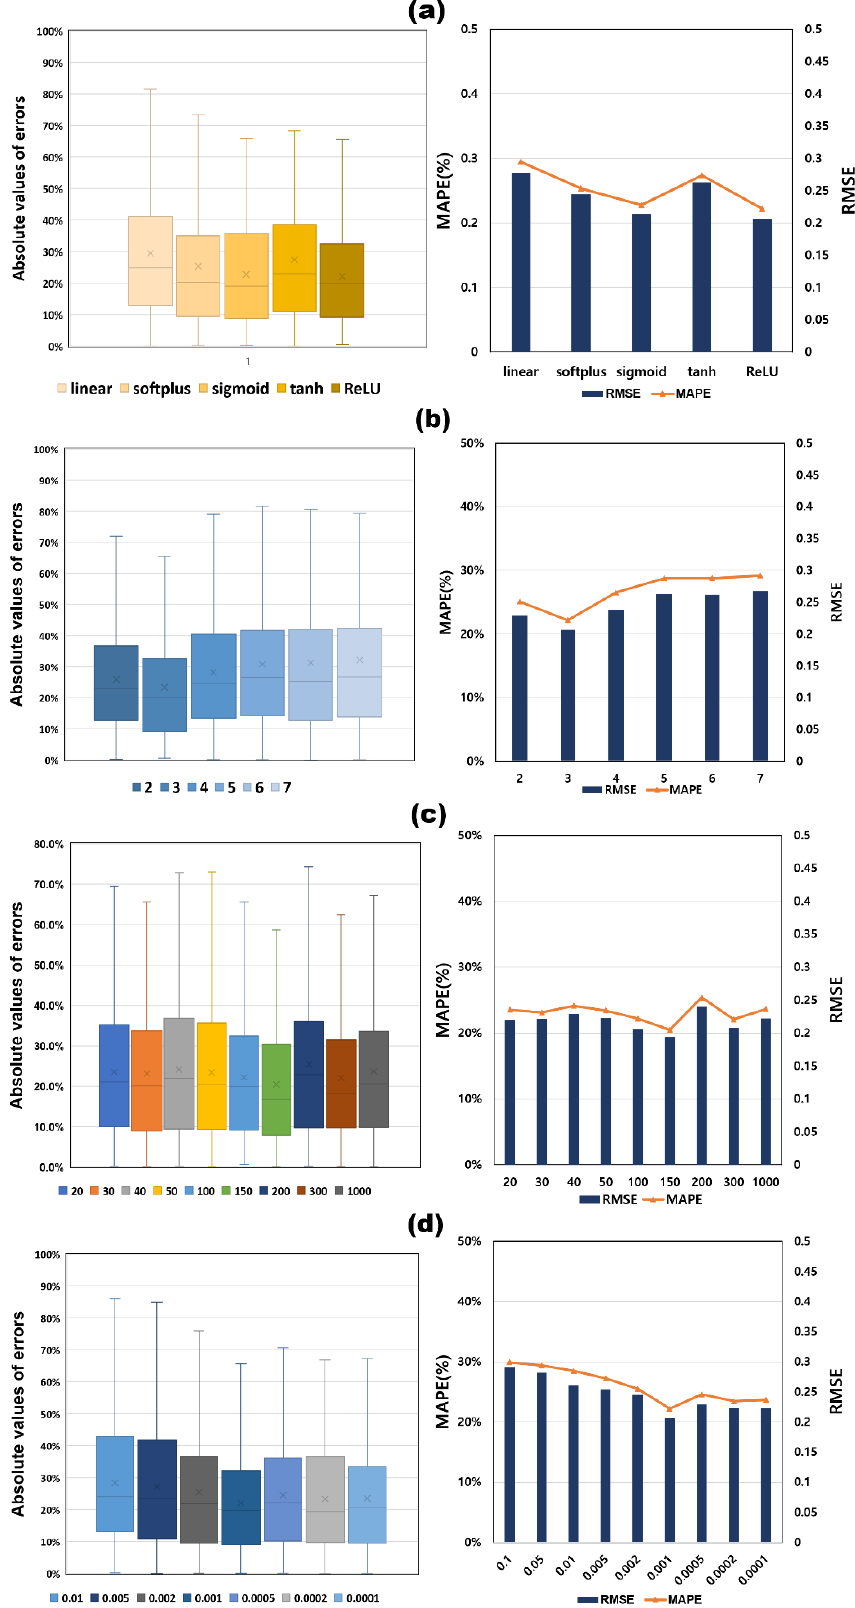
Figure 15. Sensitivity analysis results for various hyperparameters. ( a ) activation function; ( b ) number of hidden layers; ( c ) number of neurons; ( d ) learning rate.